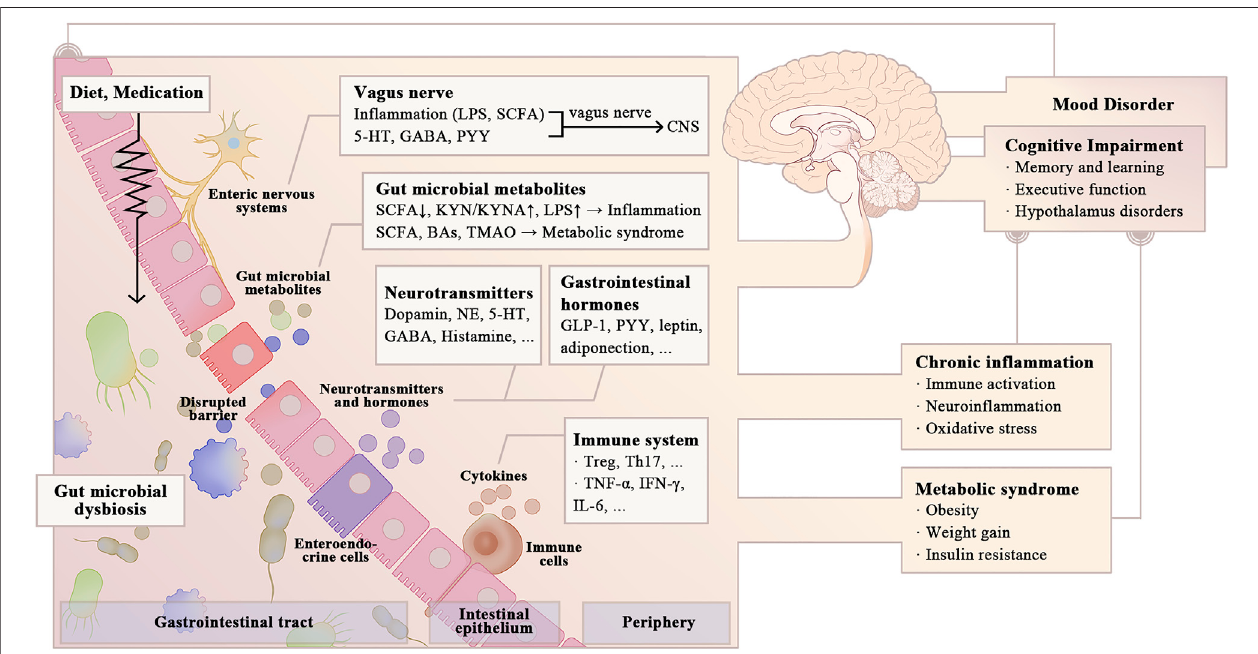
FIGURE1| PossiblepathwaysforgutmicrobialdysbiosistoaffectcognitivefunctioninBD.GutmicrobialdysbiosisiswidelyviewedinBDpatients,whichmayhave a negativeeffecton cognitive function (e.g., learning and memory, executive function, and cognitive fl exibility). Alterations in the gut microbial composition in BD patients increase intestinal permeability, promoting the release of pro-in fl ammatory cytokines and microbial-derived metabolites into the circulatory system, causing systemic in fl ammation and metabolic dysbiosis. Gut microbiota also modulates energy metabolism and cognitive function by in fl uencing the synthesis of neurotransmitters and gastrointestinal hormones, as well as the vagal-dependent gut-brain signaling. Psychiatric medications and changing diet patterns in BD patients have complex interactions with gut microbiota, thereby in fl uencing cognitive function. LPS, lipopolysaccharides; SCFA, single-chain fatty acids; GABA, γ -aminobutyric acid; PYY, Peptide YY; KYN, kynurenine; KYNA, kynurenic acid; Ba, bile acid; TMAO, trimethylamine-N-oxide; NE; GLP-1, glucagon-like peptide-1; Treg, regulatory T cell; Th, helper T cell; INF, Interferon; IL, Interleukin.